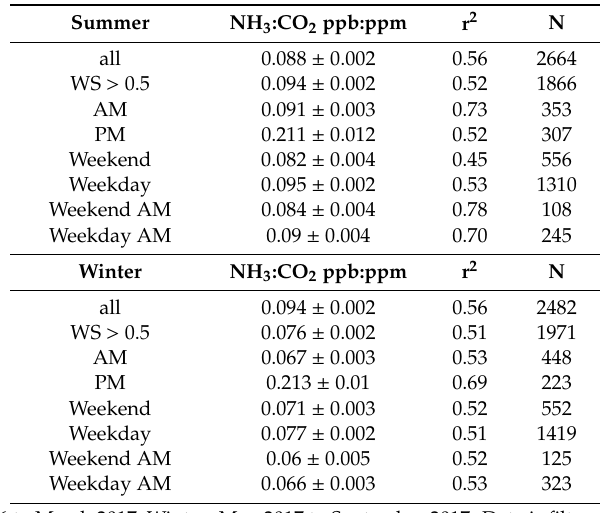
(Table A1). CO 2 :CO also di ff ers from the eastern and western sectors, with the eastern sector lower in both seasons. The correlation between NH 3 and CO 2 was weaker, ranging from 0.4 to 0.8, with the NH 3 :CO 2 ratio highest during the afternoon peak and lower during the morning peak. (Table 8).